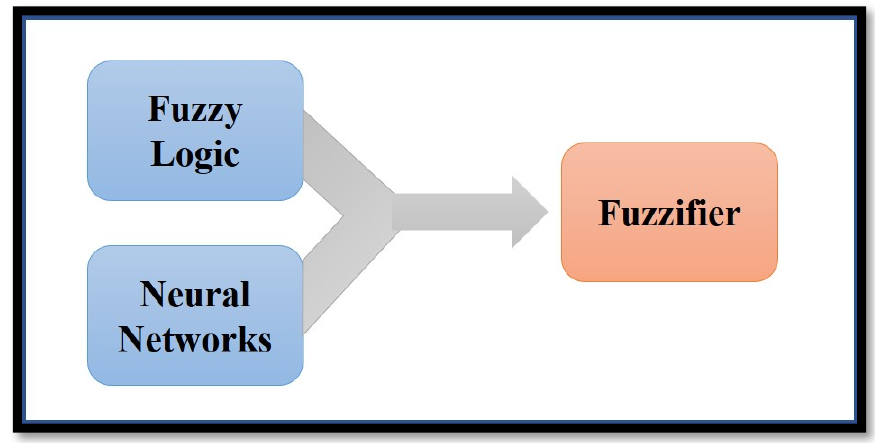
Figure 1. Combination of two technologies, i.e., Fuzzy and Neural.